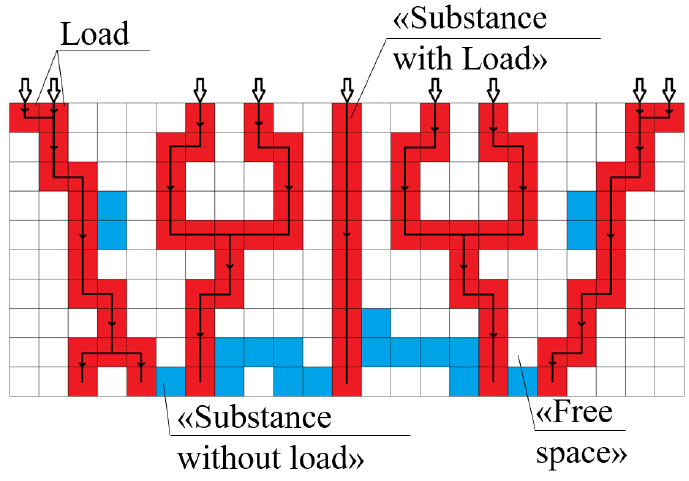
Figure 11. Young’s modulus calculation ( —“substance without load”, —“substance with load”, —“free space”, —the shortest paths.